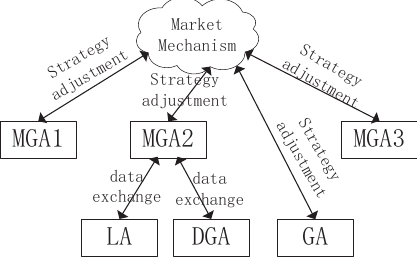
Figure 2. Multi-agent coordination strategy in hierarchical bidding and transaction structure based on blockchain